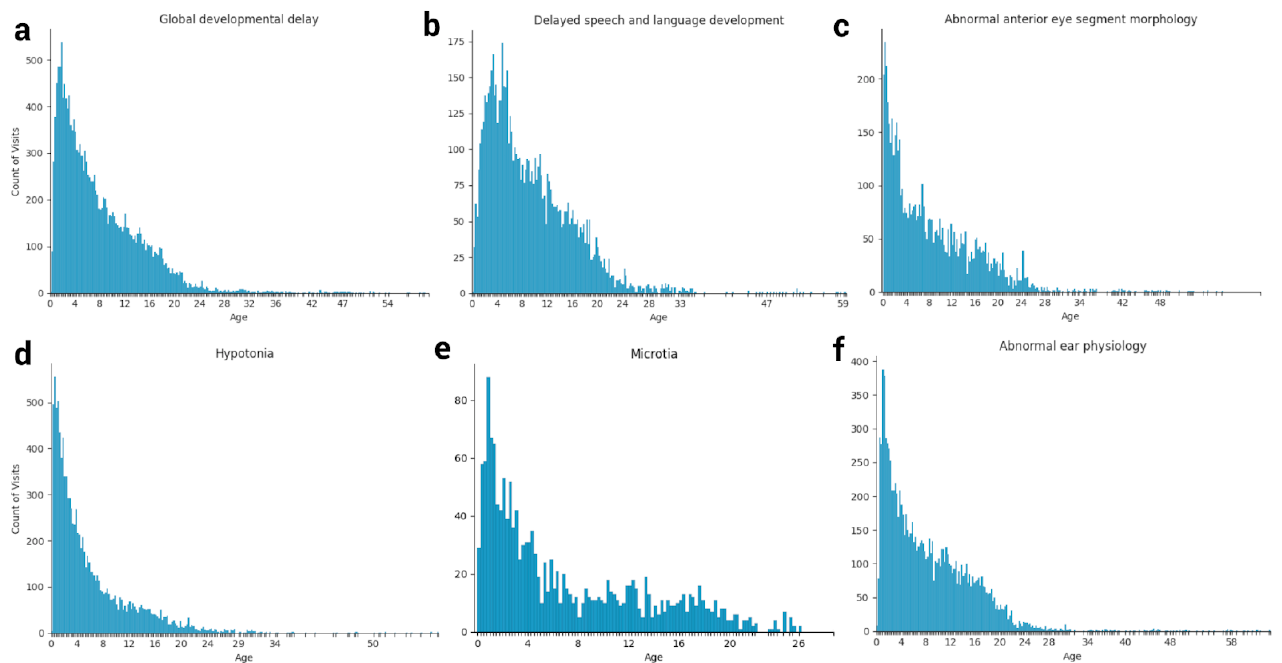
Figure 3. Snapshots of select HPO term age distributions for the Down syndrome cohort. The occurrence of various HPO terms at each patient visit reflects the longitudinal distribution (age in years) of each feature in Down syndrome, including ( a ) Global developmental delay, ( b ) Delayed speech and language development, ( c ) Abnormal anterior eye segment morphology, ( d ) Hypotonia, ( e ) Microtia, and ( f ) Abnormal ear physiology.